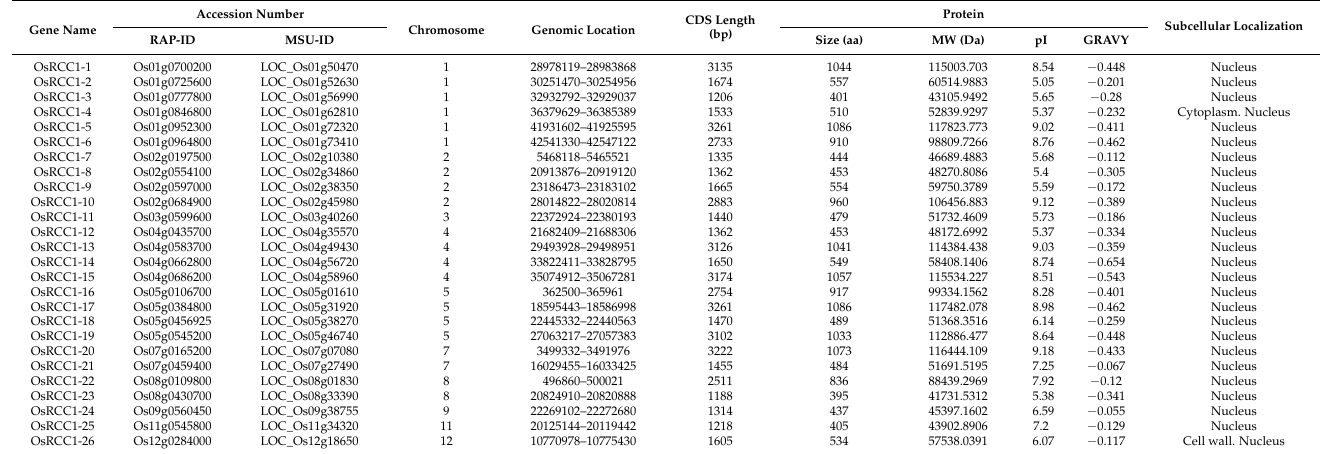
Table 1. Detailed information of the identified rice